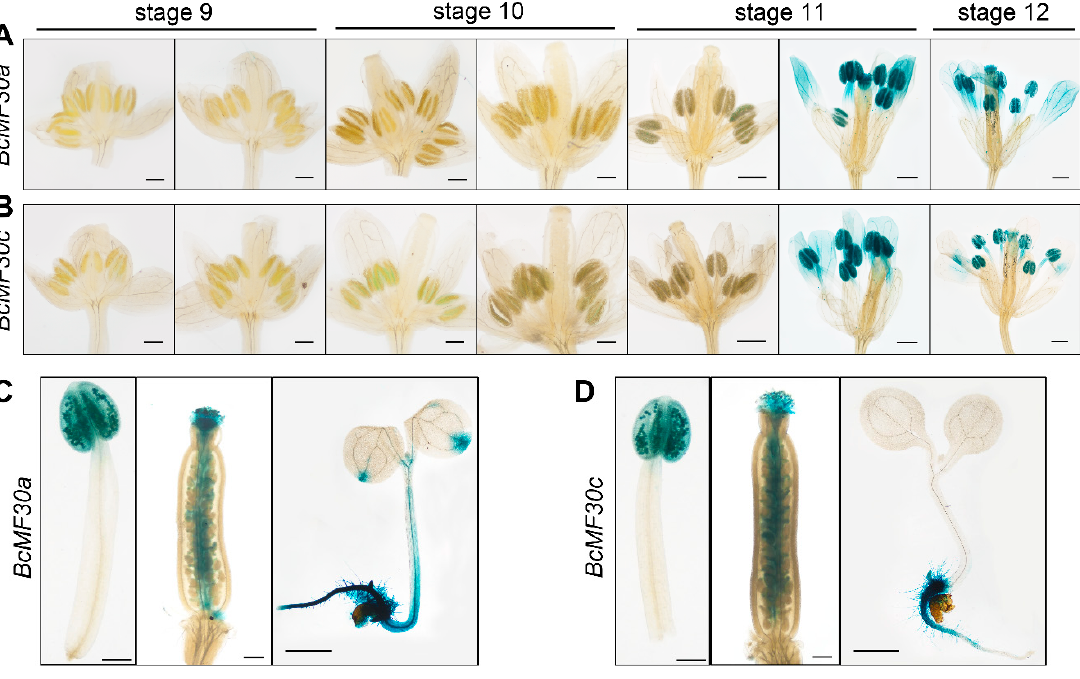
Figure 1. Spatiotemporal expression patterns of BcMF30a and BcMF30c . β -glucuronidase (GUS) staining of floral buds of ProBcMF30a:GUS ( A ) and ProBcMF30c:GUS ( B ) plants at different stages of pollen development. GUS staining of anthers, fertilized pistils, and 7-day-old seedlings of ProBcMF30a:GUS ( C ) and ProBcMF30c:GUS ( D ) plants.